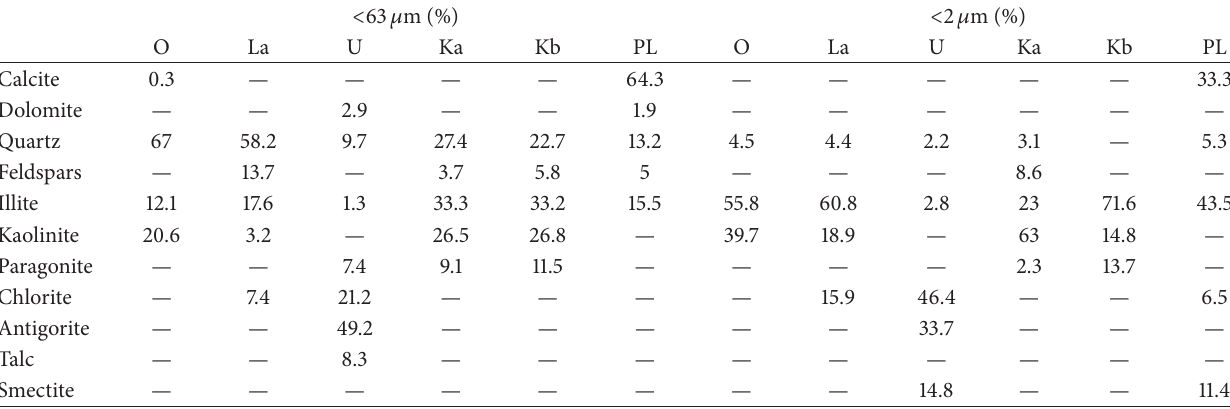
Table 1: Mineralogical quantitative analysis mean values for < 63 𝜇 m and < 2 𝜇 m fractions.